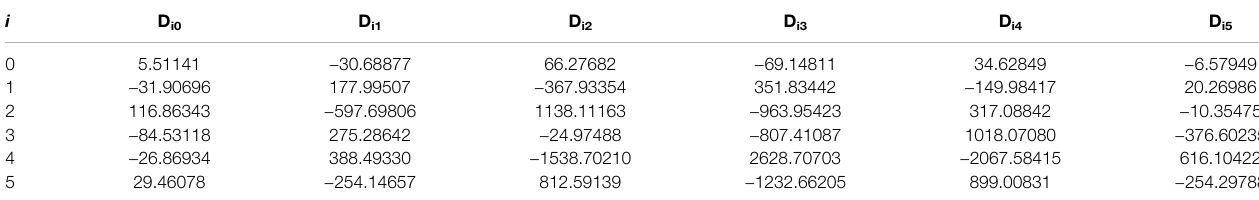
TABLE 8 | Coef fi cients D ij of ρ ( h , p ) .